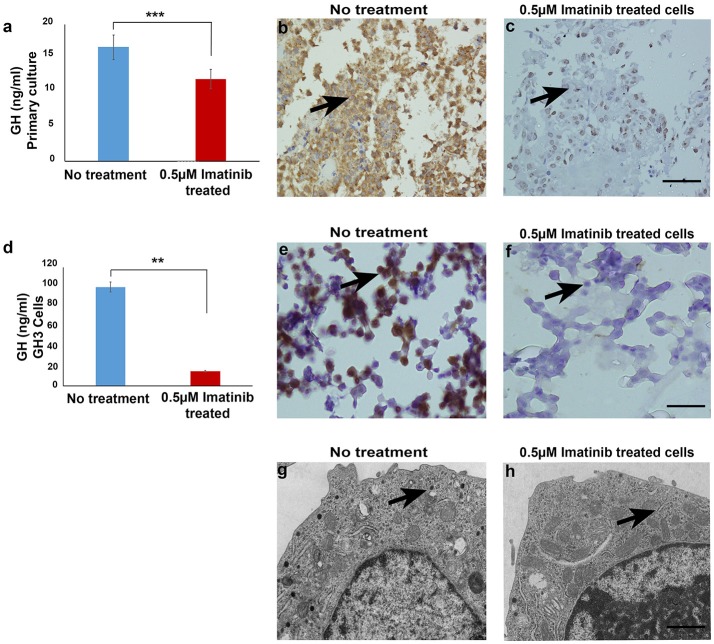
(a) Bar diagram showing reduction in growth hormone levels in culture media after treatment with 0.5 μM imatinib in primary culture of somatotropinoma cells (P < 0.0001). (b,c) Representative image of immunohistochemistry with anti-GH antibody on treated and untreated primary somatotropinoma culture. (d) Bar diagram showing reduction in GH levels in culture media of GH3 cell line after treatment with 0.5 μM imatinib (P < 0.01). (e,f) IHC of GH3 cells showing intense GH positivity in untreated and no GH staining in treated cells (20X). (g,h) Ultra-structural analysis of GH granules using electron microscopy between treated and untreated GH3 cells (6000X). **P < 0.01; ***P < 0.0001.